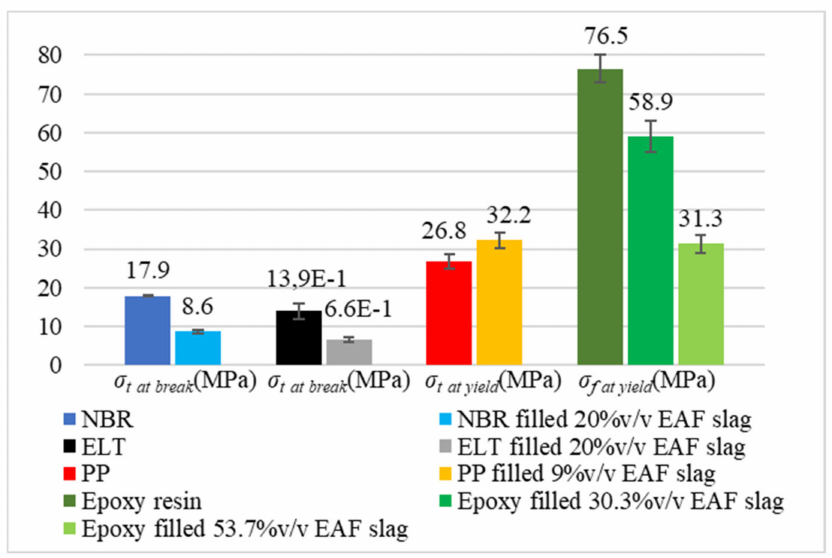
Figure 4. Influence of EAF slag as filler for NBR, ELT, PP, and epoxy resin matrix on maximum stress that coincides with stress at break or stress at yield depending on the polymer